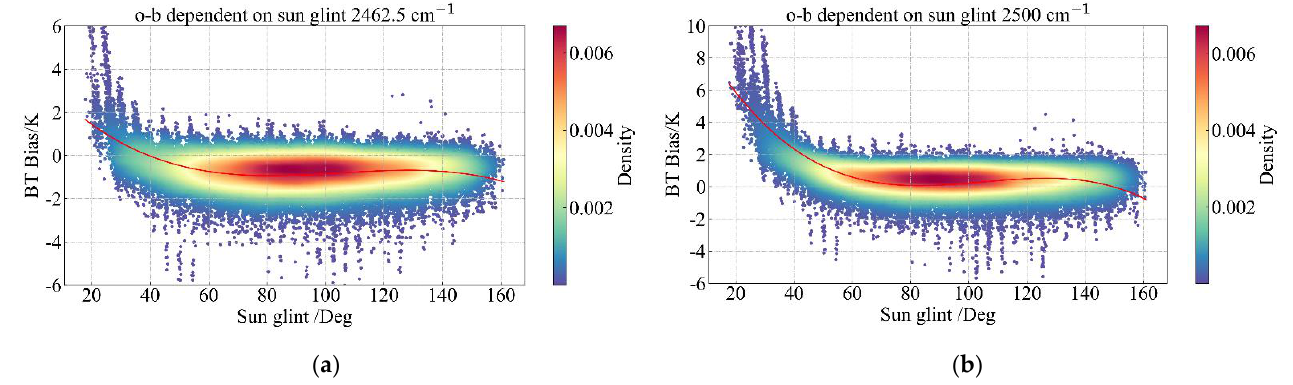
Figure 8. Fitting relationship between sun glint angle and the bias of OMB. ( a ) 2462.5 cm −1 ; ( b ) 2500 cm −1 .